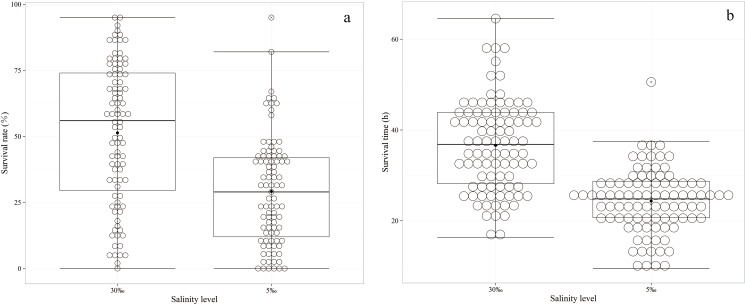
(a) Boxplot of the survival rates of the families at the half-lethal time. (b) Boxplot of the average survival times of the families. The 25th (upper line), median (inside line) and 75th (bottom line) percentiles of the families are plotted as boxes. The minima, maxima, and the observed values are shown as -, -, and ○, respectively.